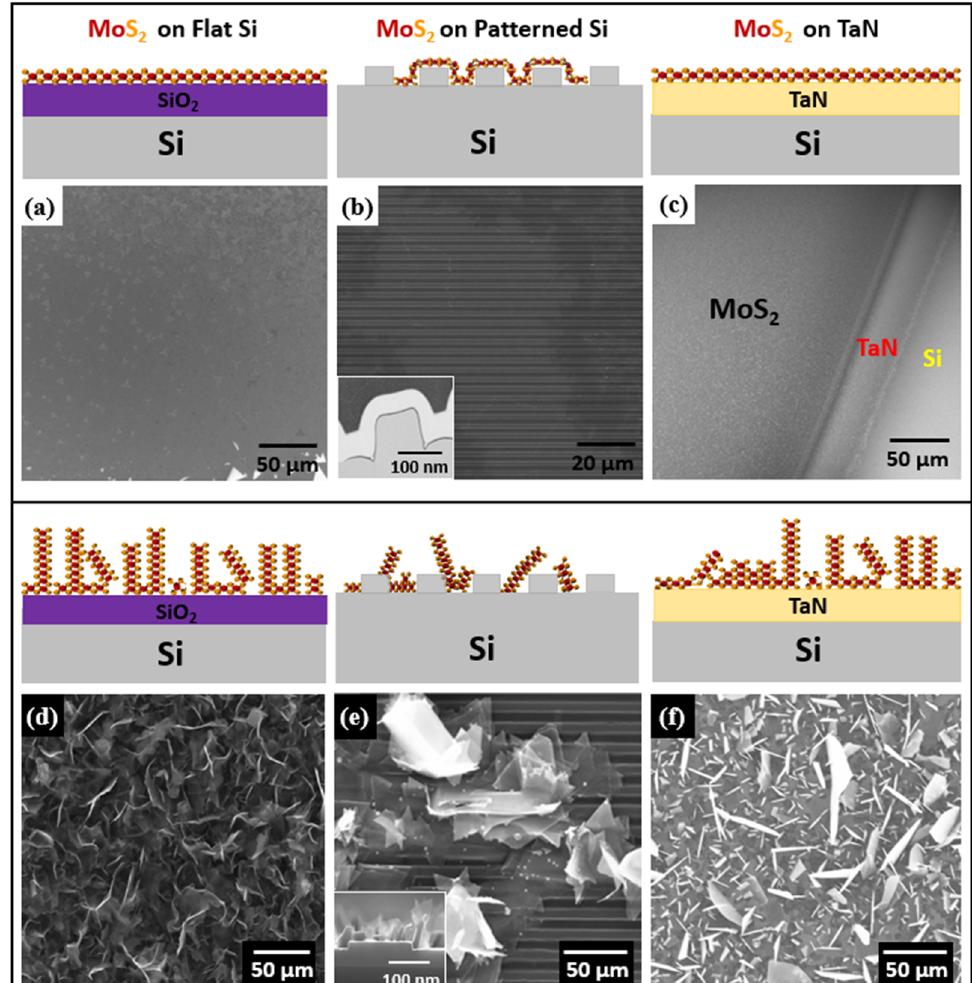
Figure 2. Schematic illustration of horizontal and vertical growth of MoS 2 using AP-CVD and SEM image ( a ) large area monolayer MoS 2 grown on flat SiO 2 /Si substrate ( b ) isolated flake of flat monolayer MoS 2 domain on patterned SiO 2 /Si; inset TEM cross sectional image shows conformal monolayer MoS 2 growth on patterned trenches (thin dark line). ( c ) flat MoS 2 on TaN. ( d – f ) vertically standing MoS 2 nanosheets ( d ) on SiO 2 /Si ( e ) on pre-patterned substrate, inset: SEM cross section ( f ) on TaN.